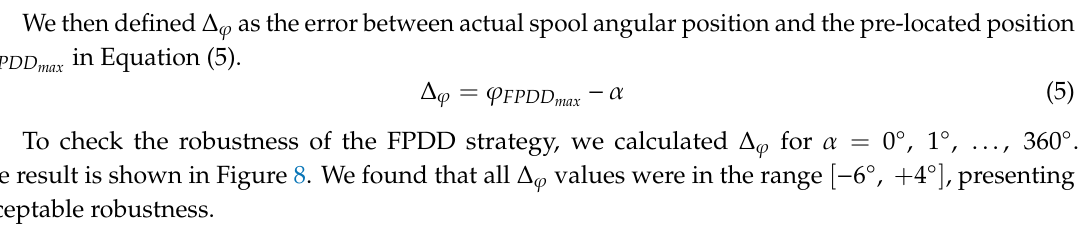
Figure 8. Robustness investigation result for FPDD : ∆ (cid:3101) for α = 0°, 1°, …, 360° .